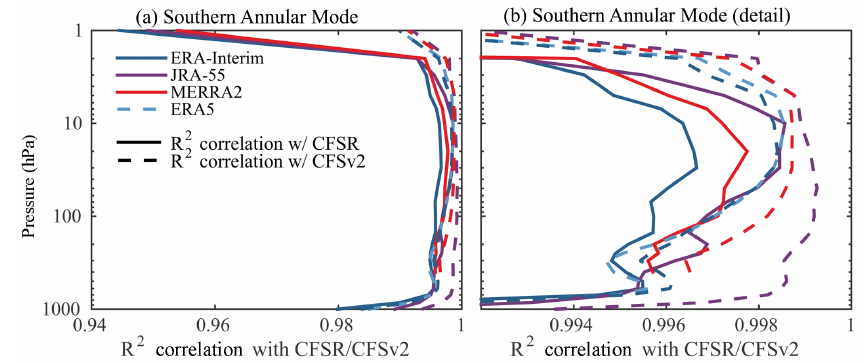
Figure 5. Comparison of the SAM in CFSR and CFSv2 with the other modern reanalyses. As in Fig. 3, the R 2 correlation is plotted: solid lines show a comparison with CFSR over the period 2005–2010, while dashed lines show a comparison with CFSv2 over the period 2011–2016. Preliminary output from the ERA5 reanalysis is available starting in 2008, and could be included in the latter comparison. We show only R 2 correlation with the SAM indices, as there were no discernable differences with the NAM indices between these two periods. Panel (b) shows the same as (a) , but we have expanded the range of the x axis to focus on middle